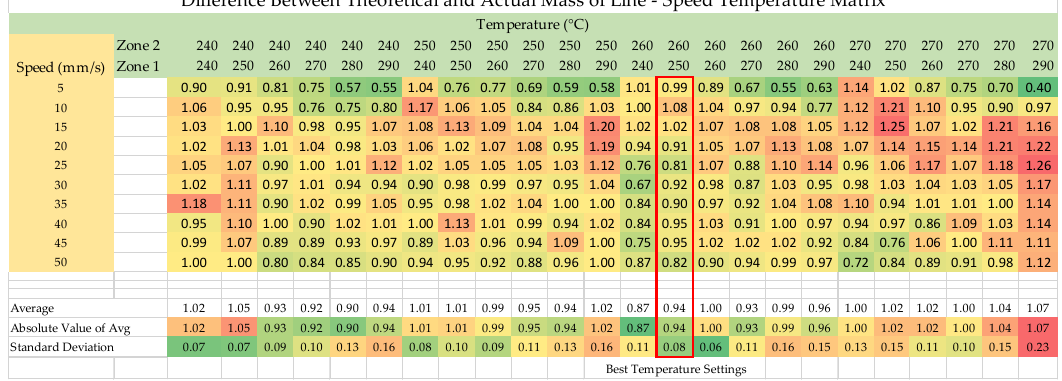
Figure 3. PC difference between the theoretical and actual mass of the line-speed temperature